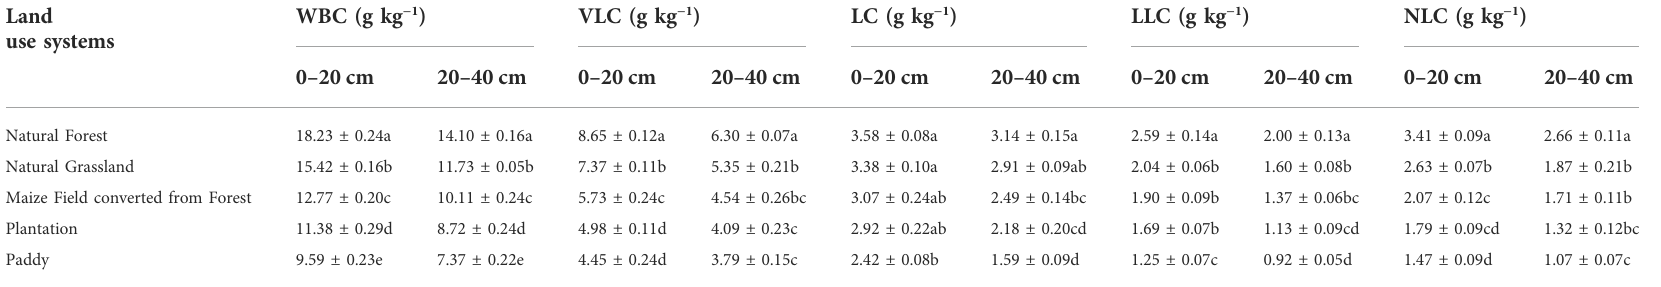
TABLE 2 Functional organic carbon pools in surface and sub-surface soil layers under diverse land-use systems. Land use